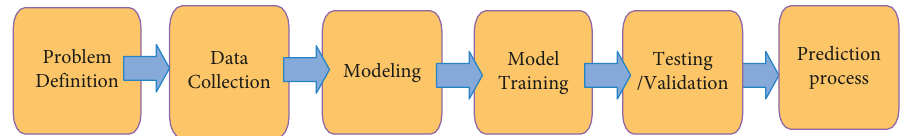
Figure 1: Steps involved in problem-solving using artificial